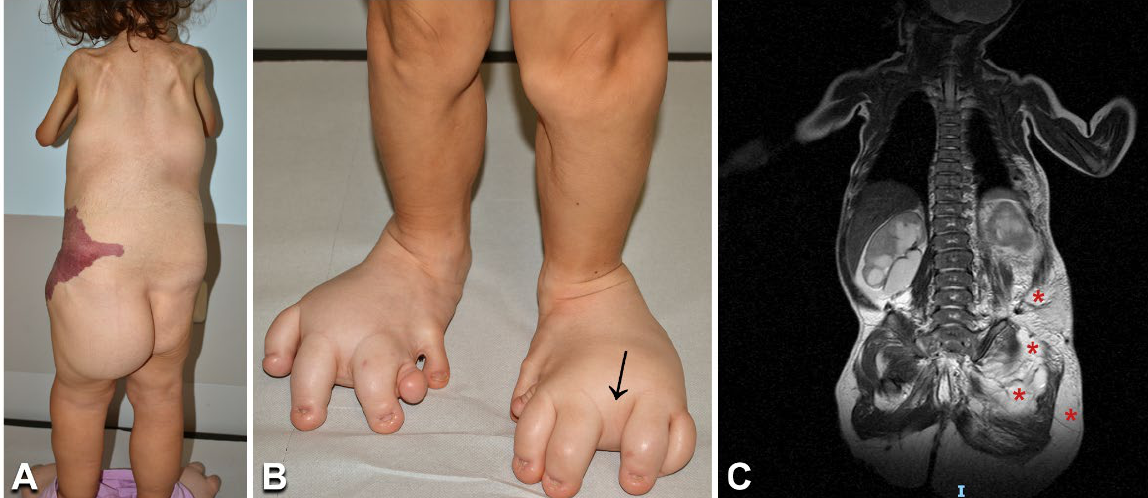
Figure 6. Clinical features and imaging findings in a 6-year-old girl with CLOVES syndrome: The child (Table 1, n. 31) presents the characteristic combined capillary–lymphatic–venous malfor-